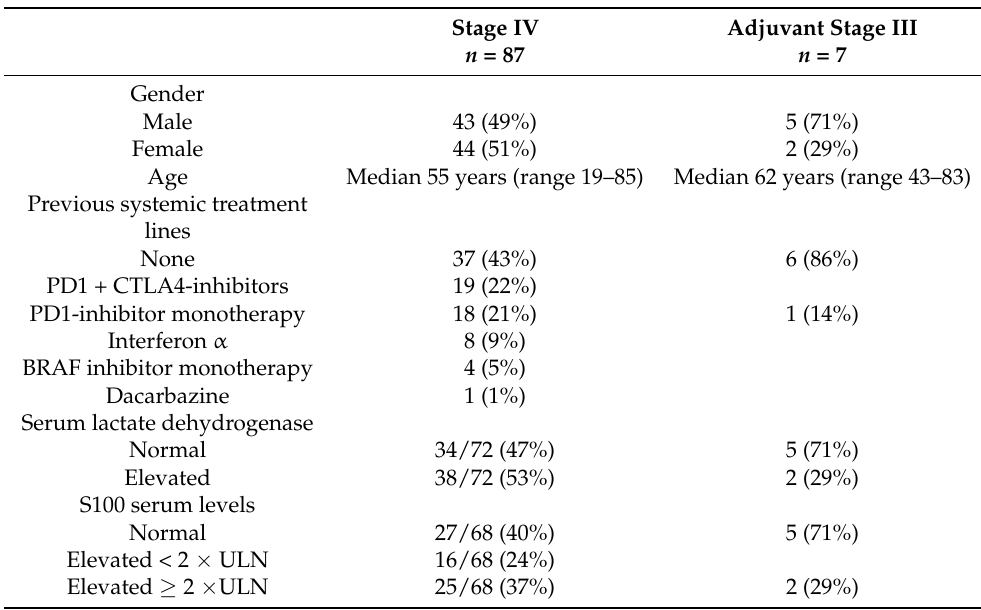
Table 1. Patient characteristics. Serum levels of lactate dehydrogenase and S100 are given for the initiation of the first BRAFi+MEKi